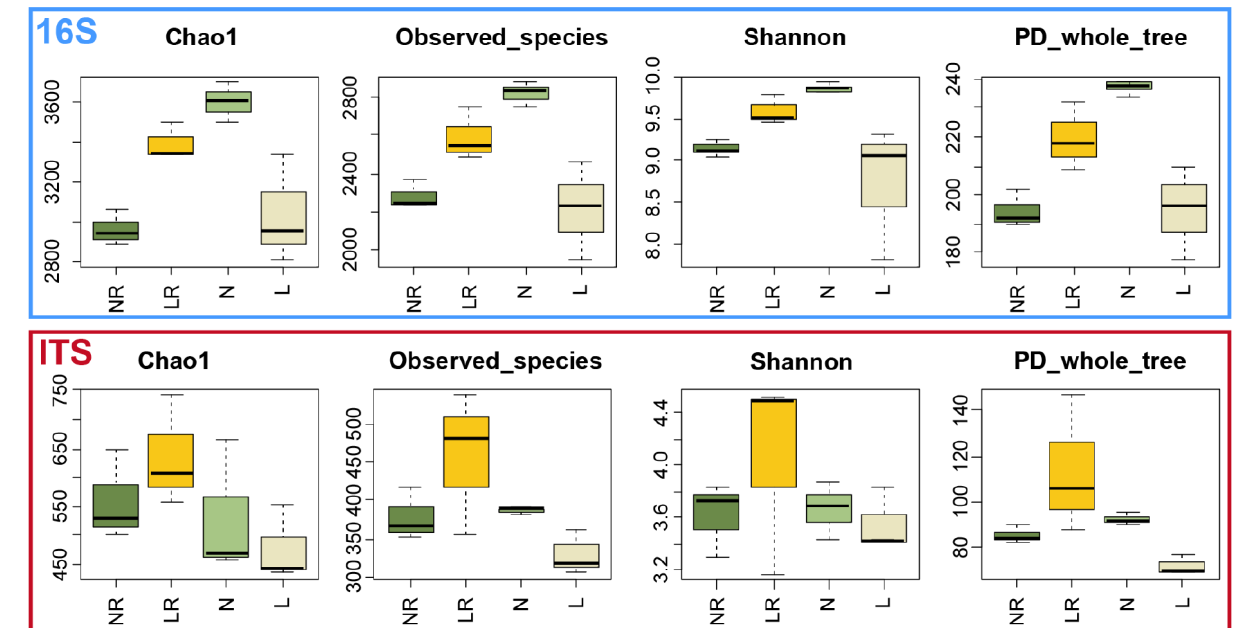
Figure 3. Alpha diversity indices of bacteria (16S) and fungi (ITS) in soil supporting highbush blueberry plants with normal or limited growth. NR-rhizosphere soil of normally growing plants; LR-rhizosphere soil of plants with limited growth; N-bulk soil of normally growing plants; L-bulk soil of plants with limited growth.